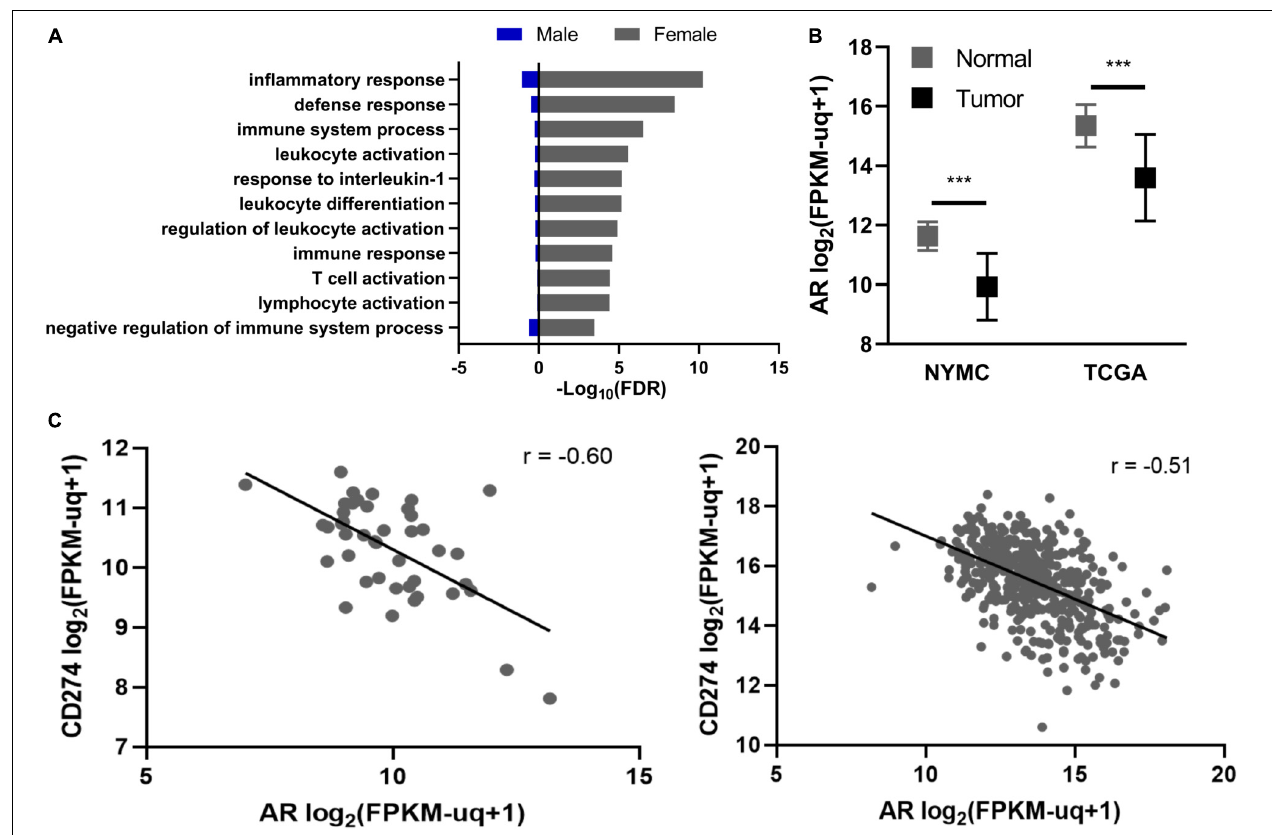
FIGURE 1 | Relationship between androgen receptor (AR), gender, and CD274 expression. (A) Enrichment of GO biological processes incorporating inflammation and immune responses. (B) AR expression in primary PTC tissue (Tumor) vs. normal adjacent thyroid tissue (Normal) in the New York Medical College (NYMC) and The Cancer Genome Atlas (TCGA) datasets. AR expression was compared using Student’s and Welch’s paired t -tests for the NYMC and TCGA datasets, respectively. (C) Regression analysis of CD274 and AR mRNA levels in NYMC (left) and TCGA (right) tumors. r represents Pearson’s correlation coefficient. FPKM-UQ, Fragments per kilobase million-upper quartile normalized. *** p <